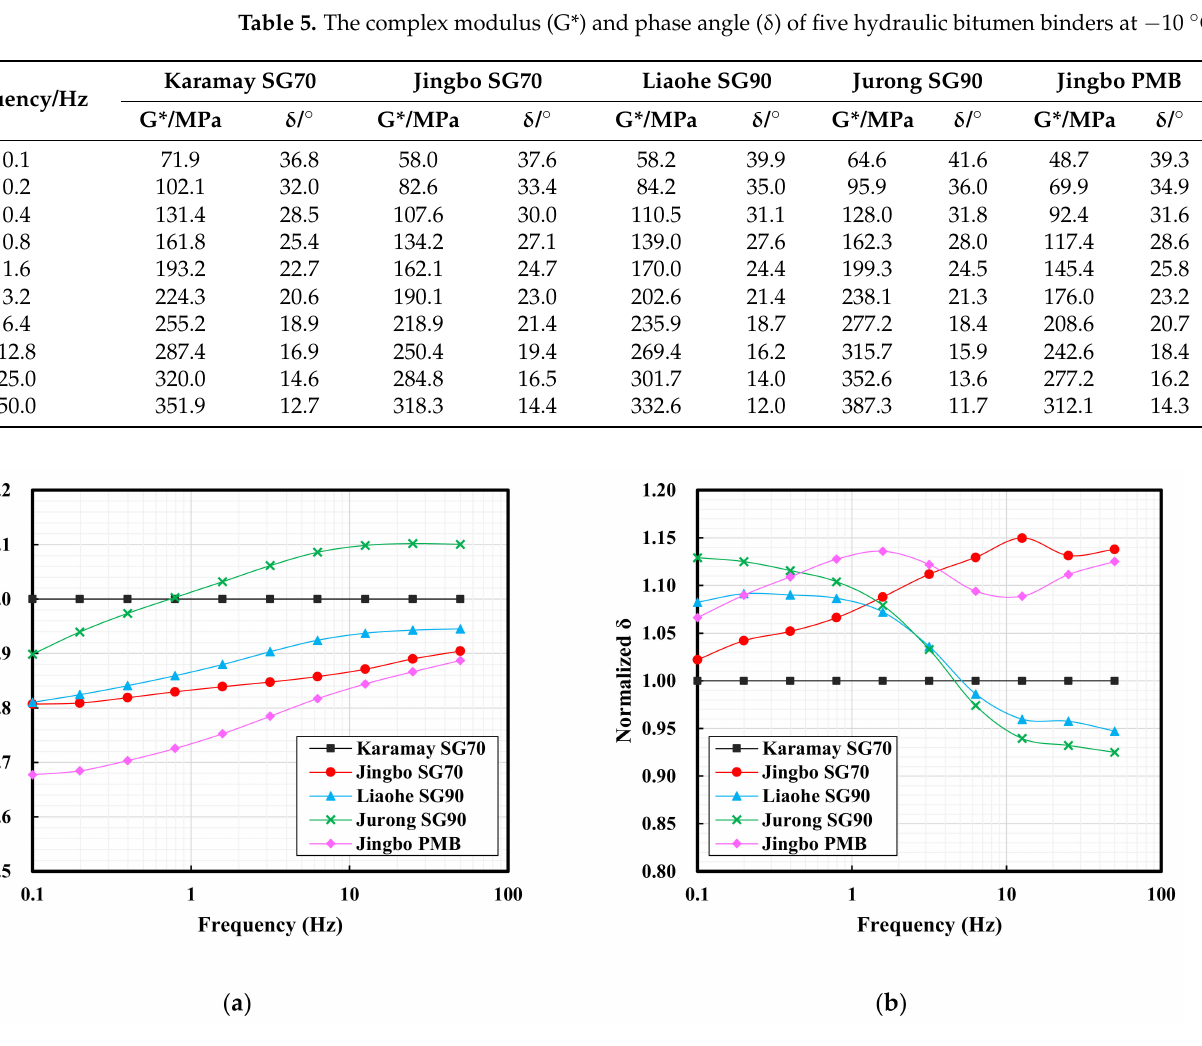
Figure 4. The complex modulus ( a ) and phase angle ( b ) of five hydraulic bitumen binders at − 10 ◦